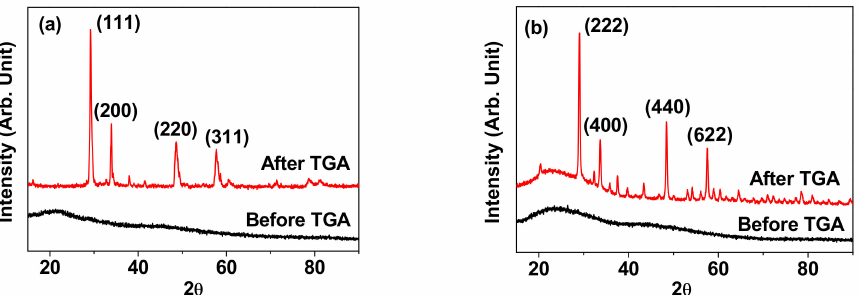
Figure 3. XRD patterns before (bottom spectra) and after TGA (top spectra) of the PAA-coated Ln 2 O 3 NPs [Ln = ( a ) Tb and ( b ) Ho]. Only the intense peaks were representatively assigned with (hkl) Miller indices for the XRD patterns after TGA.